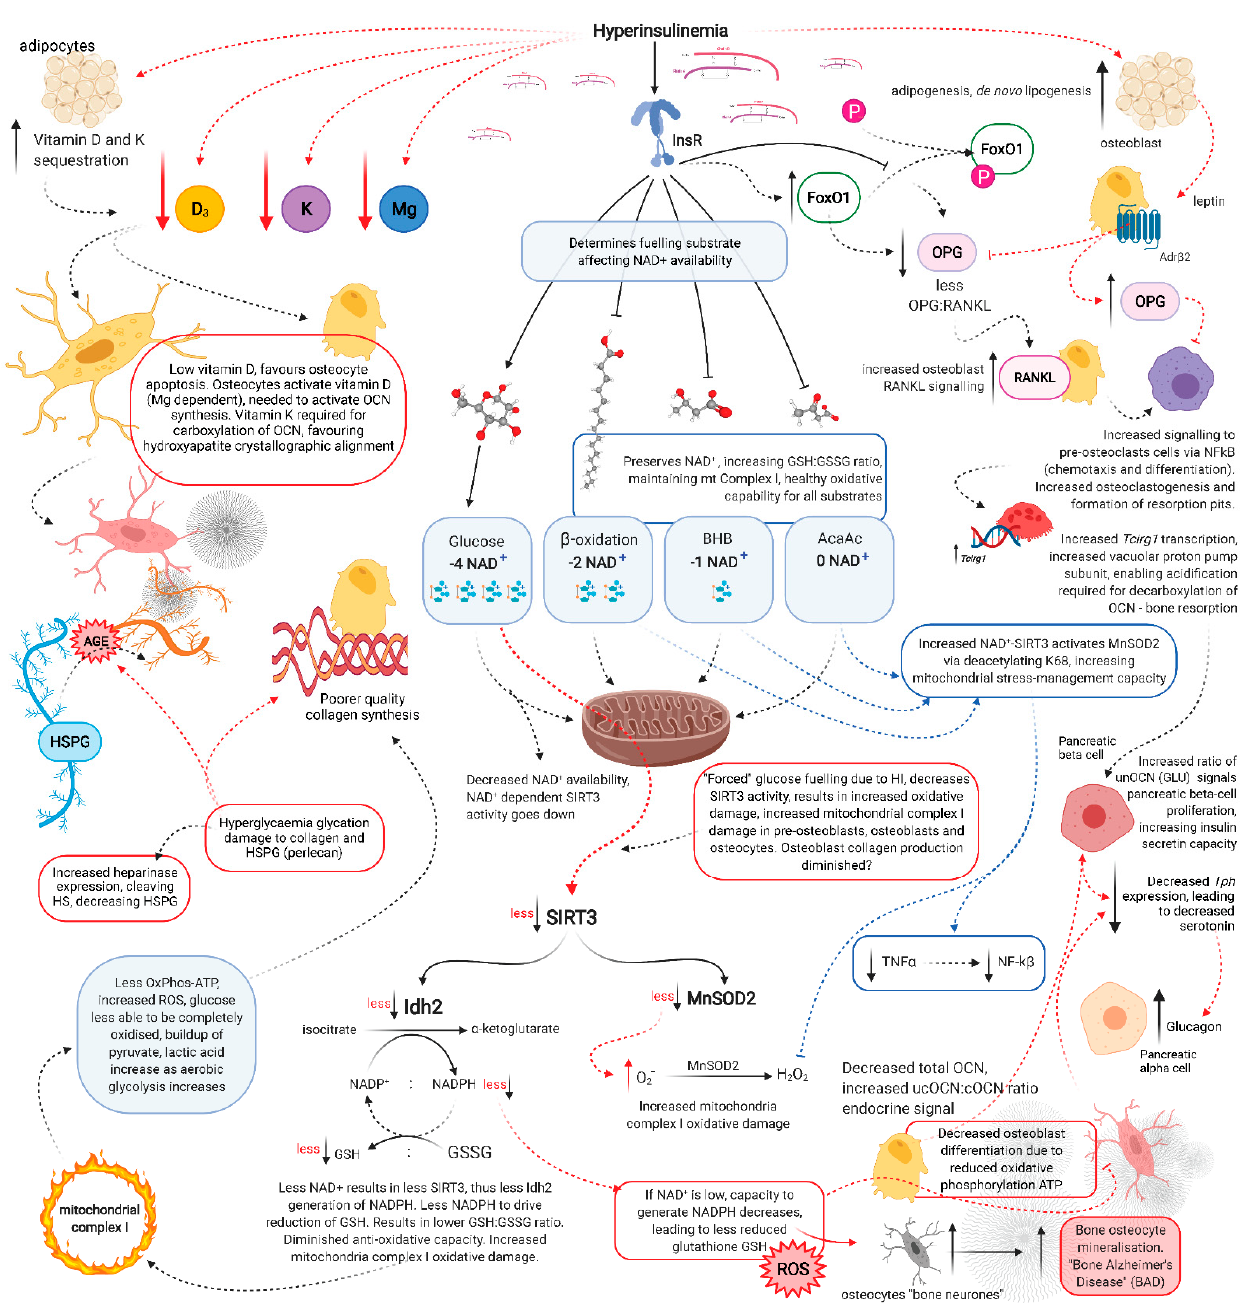
Figure 2. Schematic representation of hyperinsulinaemia effects on cellular oxidative state, and bone homeodynamics. Acetoacetate (AcAc), adenosine triphosphate (ATP), advanced glycation end-products (AGE), beta-adrenergic receptor 2 (AdrB2), beta-hydroxybutyrate (BHB), heparan sulphate (HS), heparan sulphate proteoglycan (HSPG), hydrogen peroxide (H 2 O 2 ), hyperinsulinaemia (HI), insulin receptor (InsR), isocitrate dehydrogenase 2 (Idh2), forkhead box O1 (FoxO1), glutathione oxidised form (GSSG), glutathione reduced form (GSH), lysine 68 (K68), magnesium (Mg), manganese superoxide dismutase 2 (MnSOD2), nicotinamide adenine dinucleotide (NAD+), nicotinamide adenine dinucleotide phosphate (NADP+), nuclear factor-kB (NF-kB), osteocalcin carboxylated (Gla-OCN or cOCN), osteocalcin un(der)carboxylated (Glu-OCN or ucOCN), osteoprotegerin (OPG), oxidative phosphorylation (OxPhos), receptor activator of nuclear factor-kB ligand (RANKL), reactive oxygen species (ROS), sirtuin 3 (SIRT3), superoxide (O 2 − ), tumour necrosis factor α (TNF α ), T cell immune regulator 1 ( Tcirg1 ), tryptophan hydroxylase ( Tph ), vitamin D (D 3 ), and vitamin K